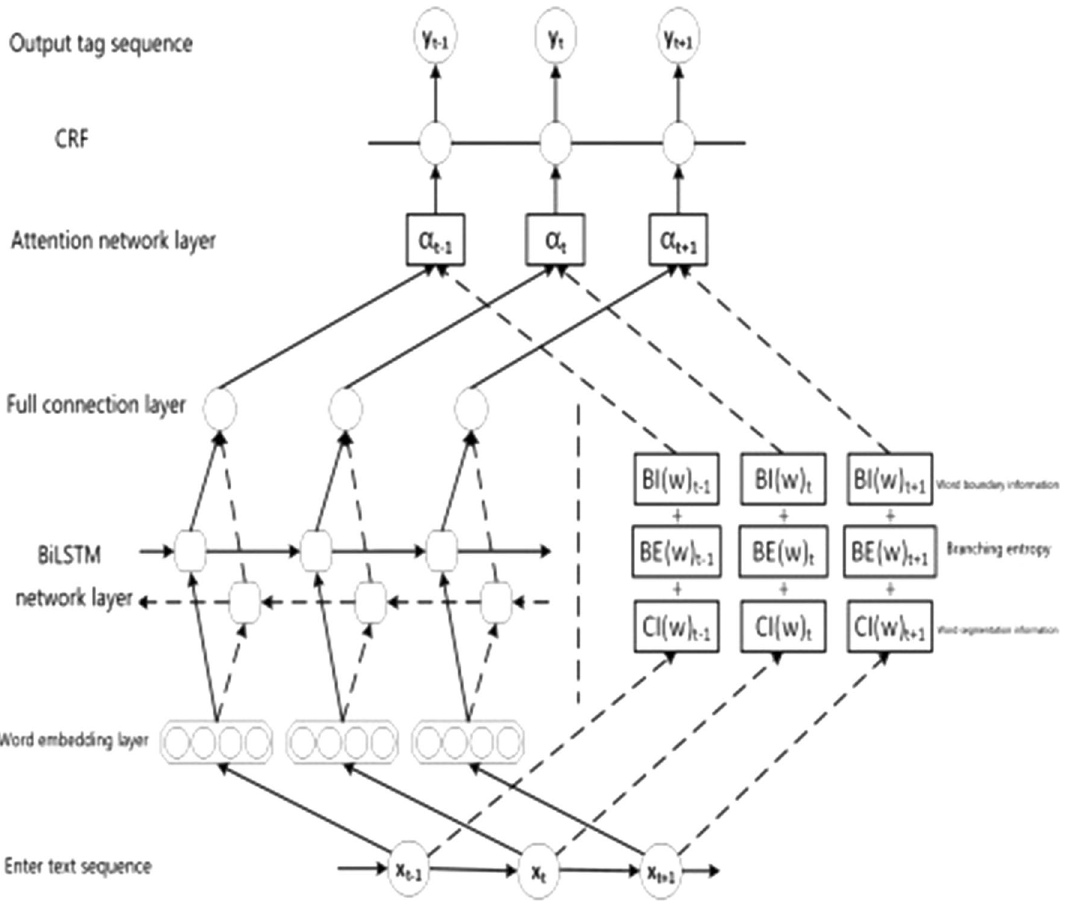
Fig. 4 Schematic diagram of boundary enhanced neural network